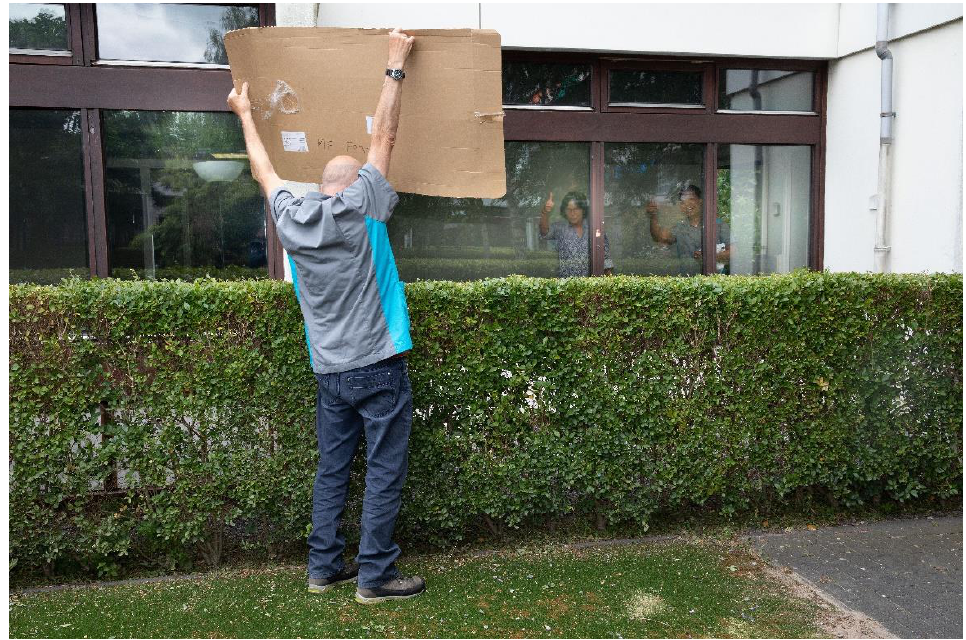
Figure 6. Pictures of community researcher doing paid care work with protest sign.